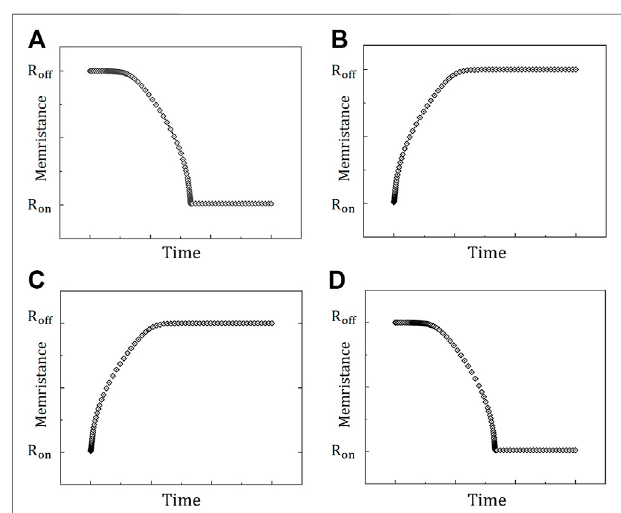
FIGURE 3 | In fl uence of the memristor access direction and excitation direction to memristance. (A) Memristor is positively connected and positive excitation is applied (B) Memristor is positively connected and negative excitation is applied. When the memristor is connected in reverse,